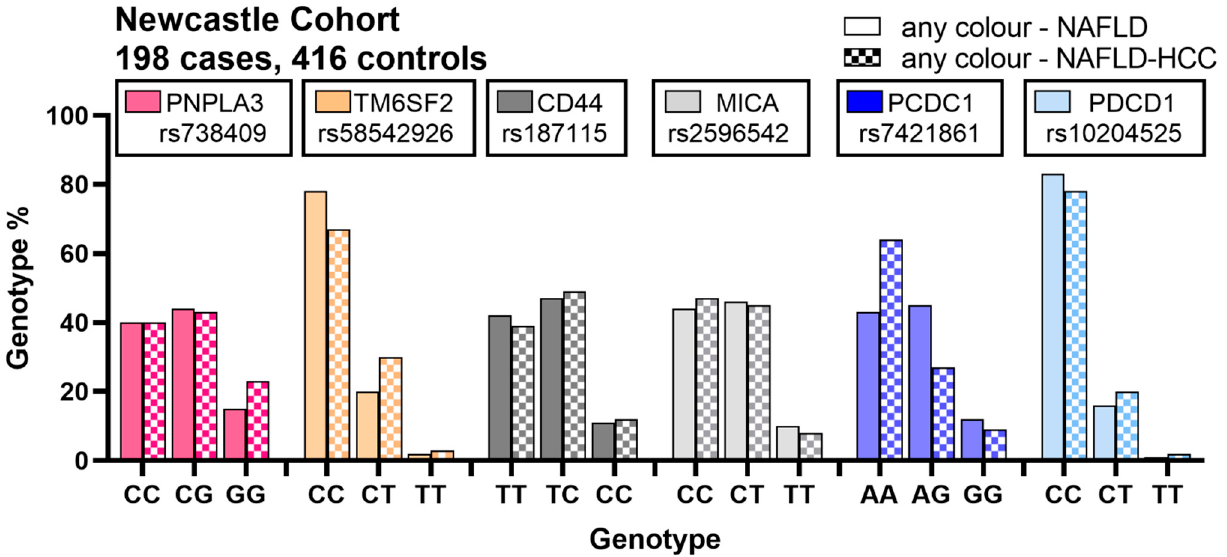
Figure 1. Allele frequencies of candidate SNPs in Newcastle